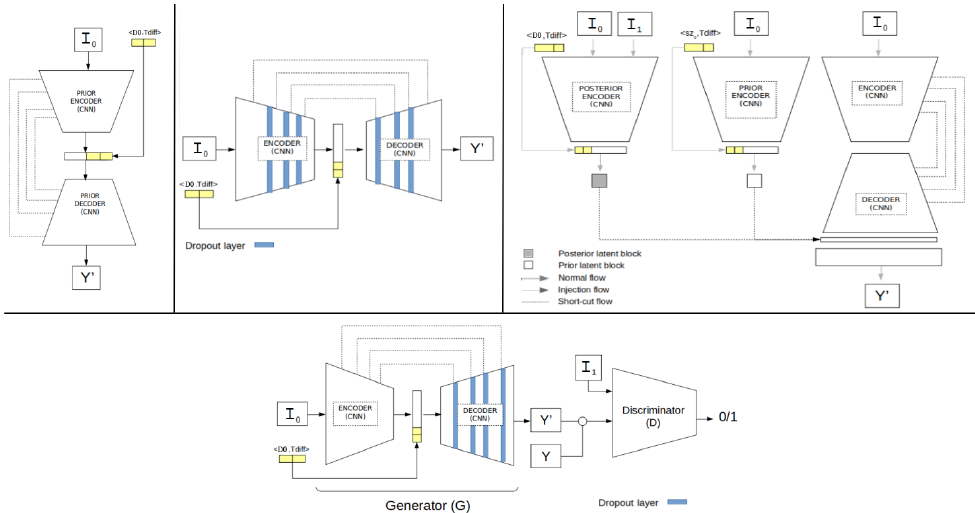
Figure 4. Four alternative network architectures adapted for lung nodule growth estimation. At the top, we have the U-ResNet(U-Net), the generative Bayesian dropout (BAYES_TD), and the probabilistic U-Net (SPU). Below, we find the Pix2Pix cGAN network